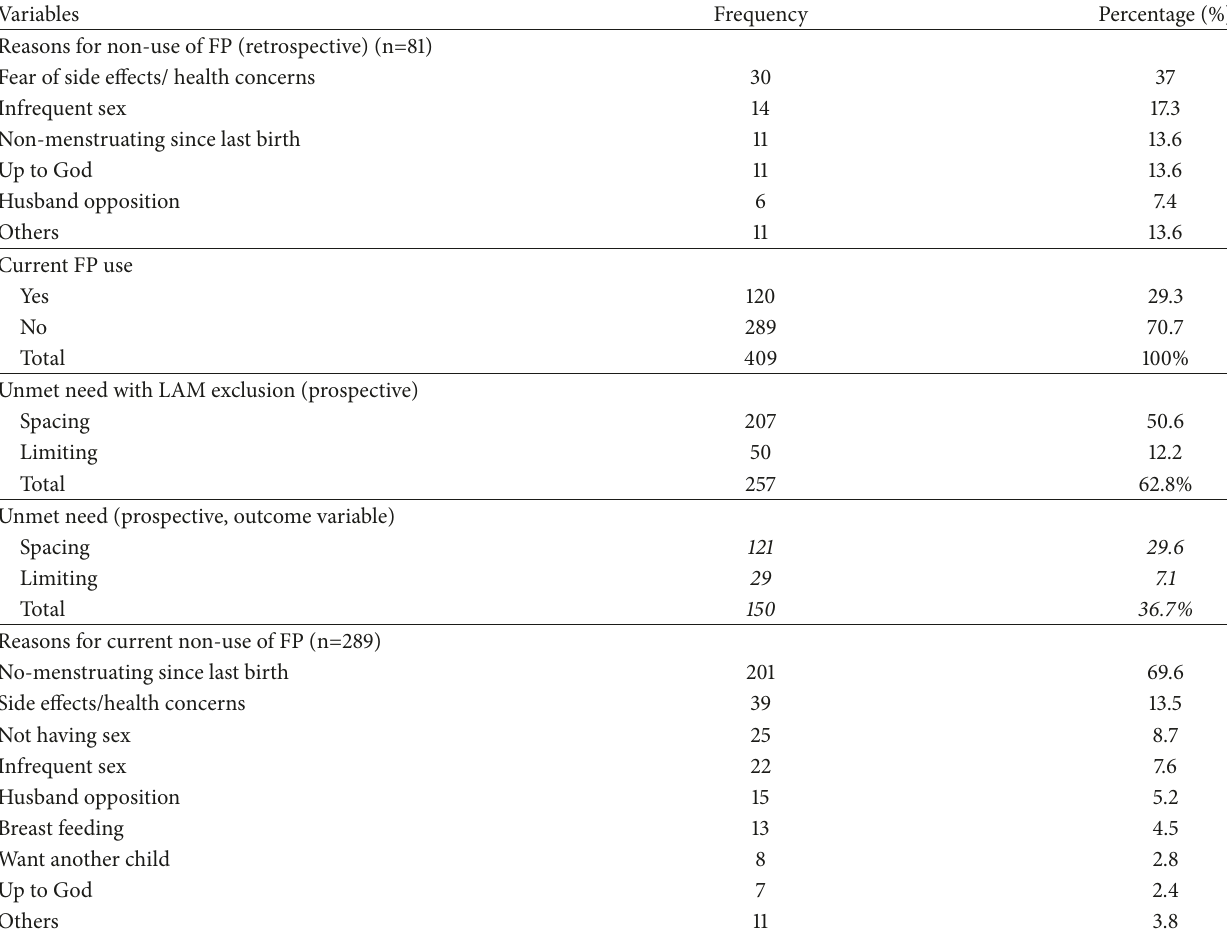
Table 3: Unmet need for FP, FP use, and reasons for nonuse of FP in EPPP, in Tahtay Koraro, Tigray, Ethiopia, 2014. Variables Frequency Percentage